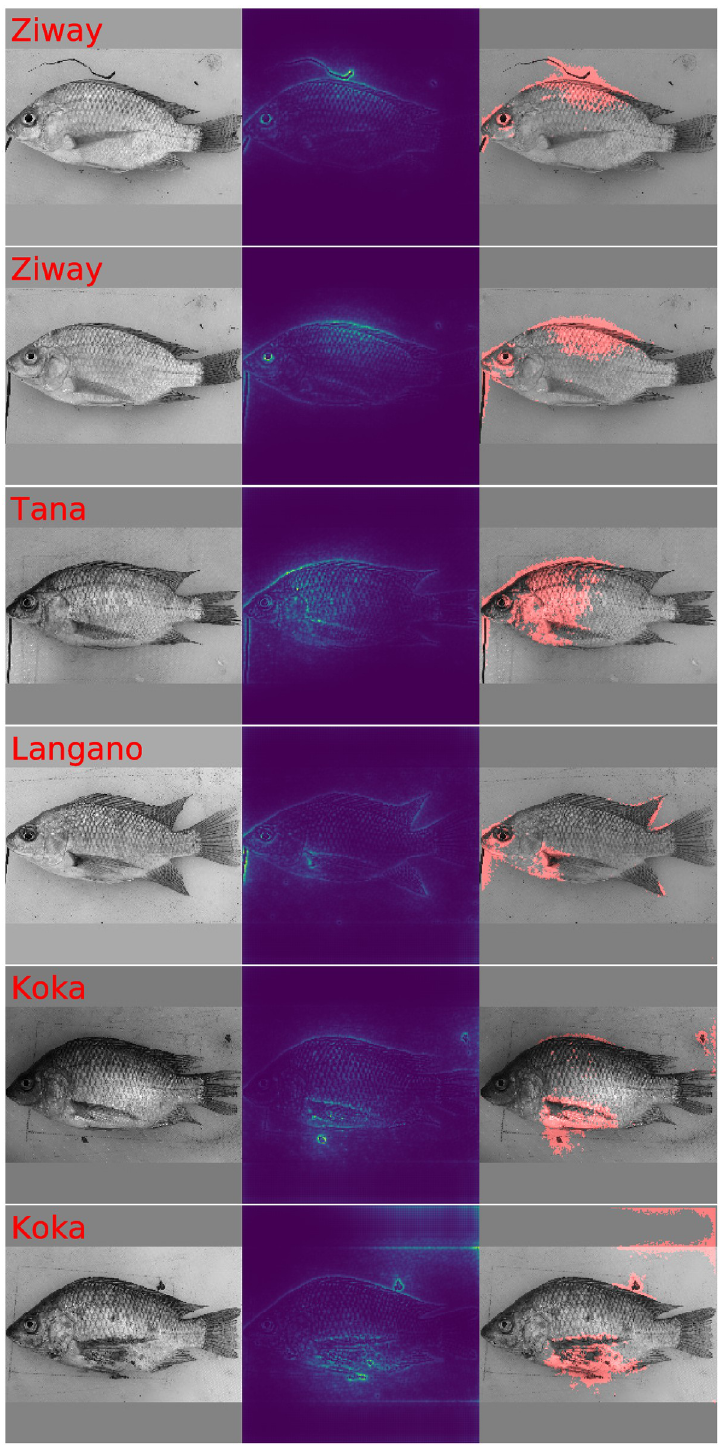
Fig 9. Selected LPR diagnostic plots with visible contamination by technical artifacts. This figure illustrates fish images, LPR saliency maps and diagnostic plots which display fish images and red color masks to highlight significant image features. All images contain indications that genuine Nile tilapia body features are considered relevant for predicting the lake of origin. It is however also obvious that features in the image background, dirt particles and the presence of the fixation pin provide rogue information which aids predicting the respective lake of